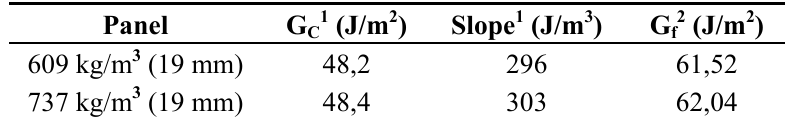
Table 1. Initiation toughness G and specific fracture energy G 90 mm